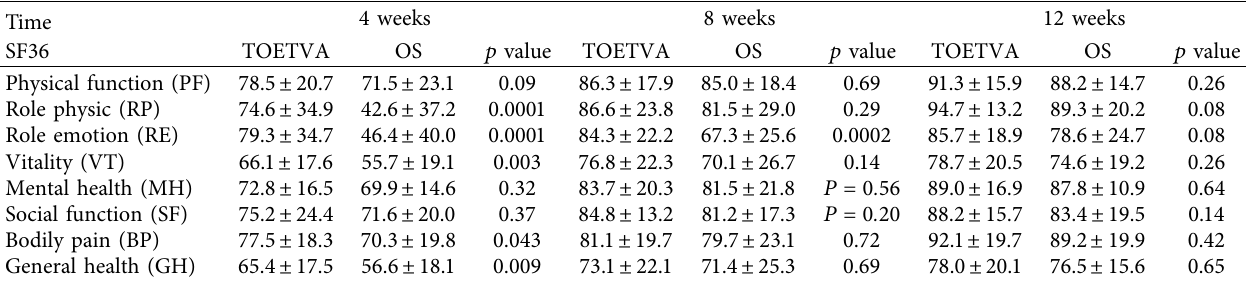
Table 5: SF-36 score comparison between the TOETVA group and open surgery group at 4 weeks, 8 weeks, and 12 weeks after surgery.